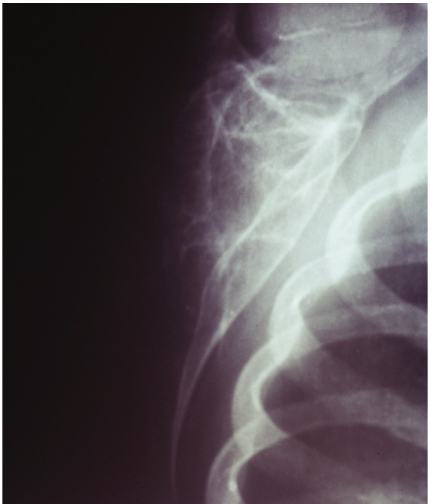
Figure 5: Postoperative scapular view radiograph of the right scapula. Five-year